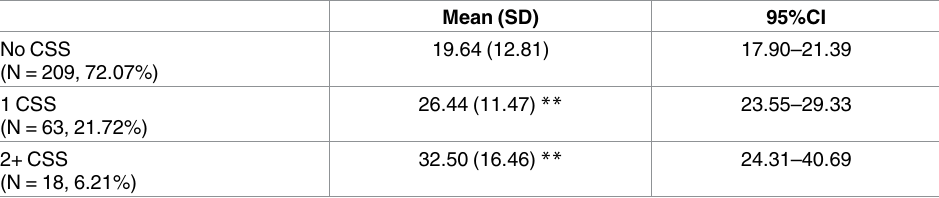
Table 4. Comparison among No CSS patients and CSS